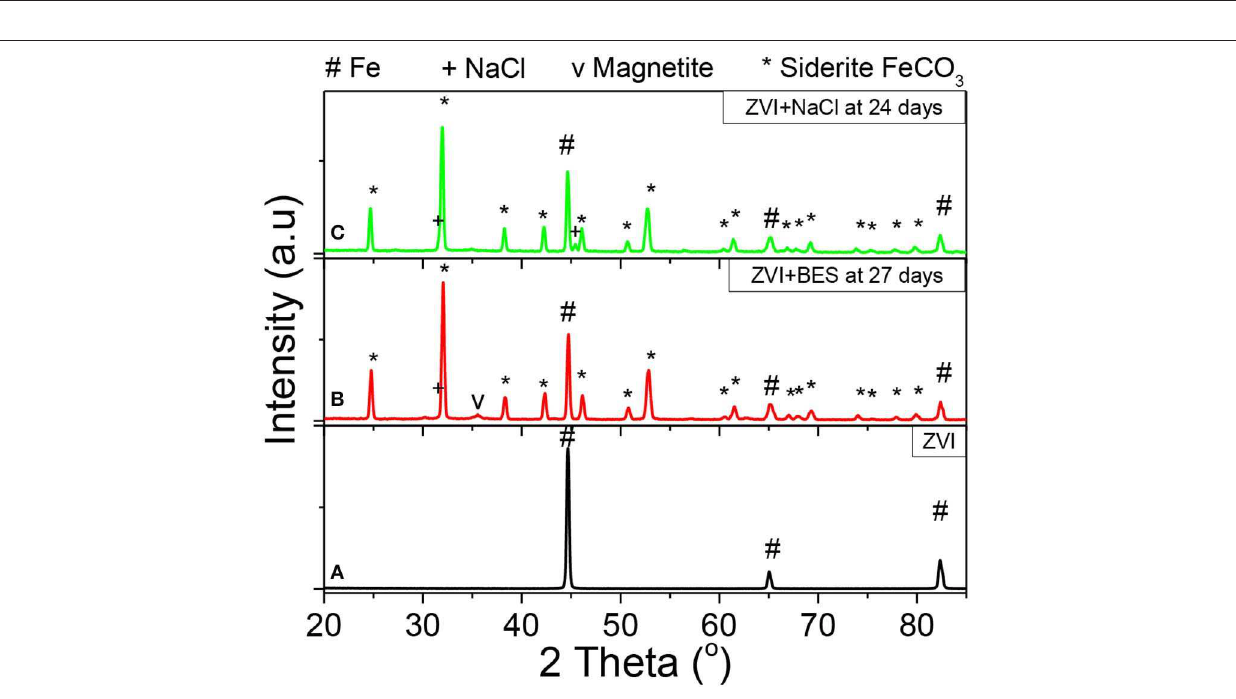
and CO 2 to CH 4 by hydrogenotrophic methanogens (Equation 2) at an in-situ biological process or at ex-situ biological